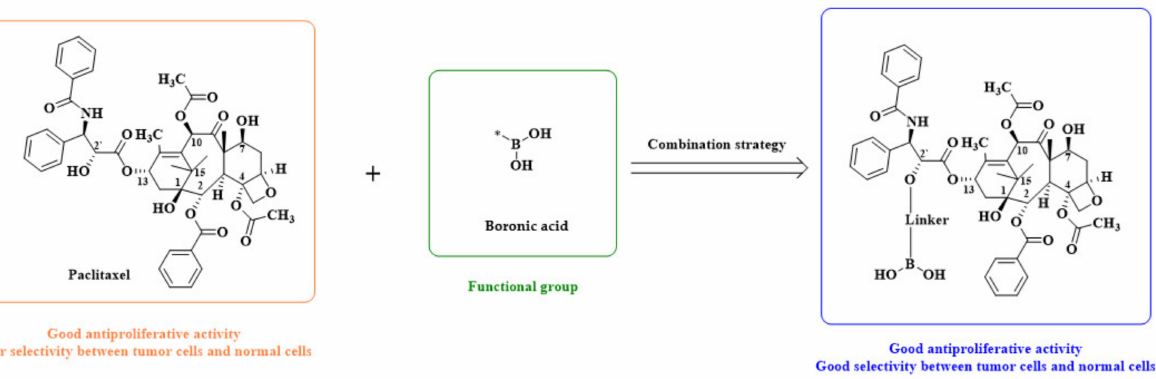
Figure 1. Combination strategy of designing paclitaxel derivatives by linking paclitaxel (as a parent drug) with a boronic acid (as the functional group) via ester bond or carbonate